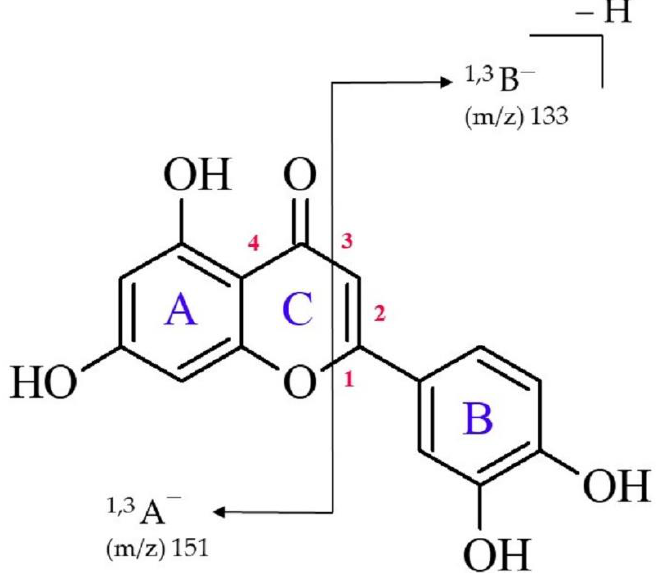
Figure 1. Chemical structure of luteolin with the numeration of bonds within the C ring and the indication of retrocyclization cleavages (RDA fragmentation) observed in this